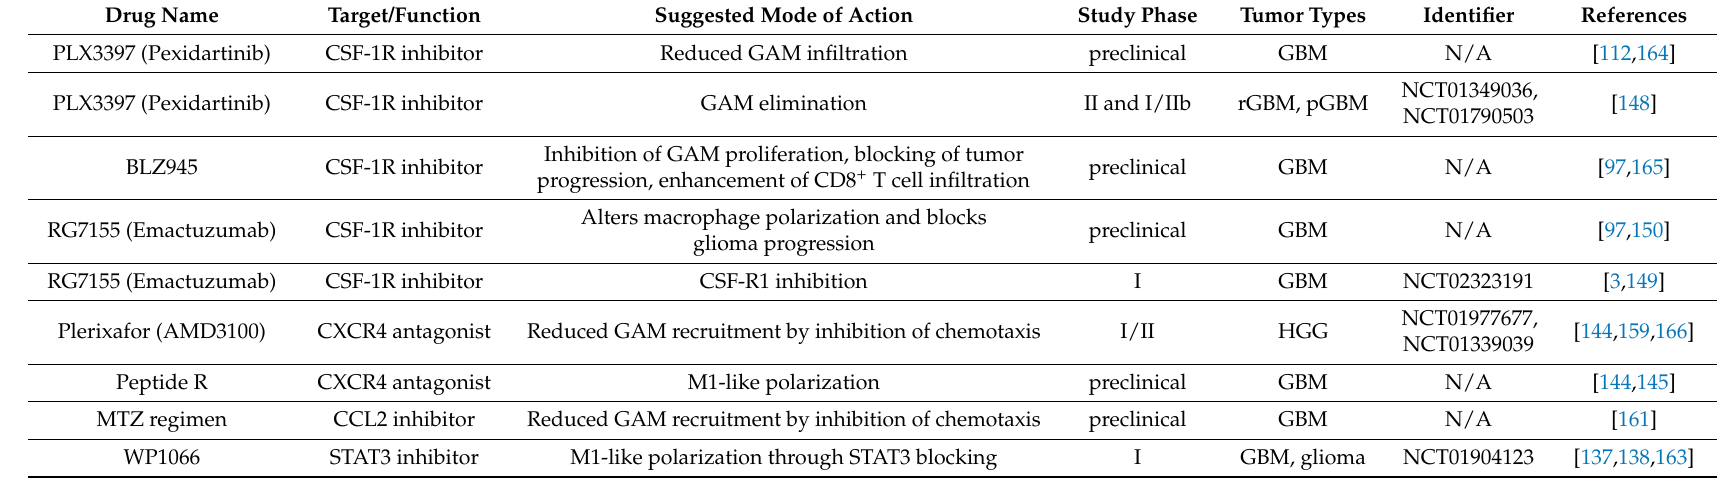
Table 2. Therapeutic drugs to target